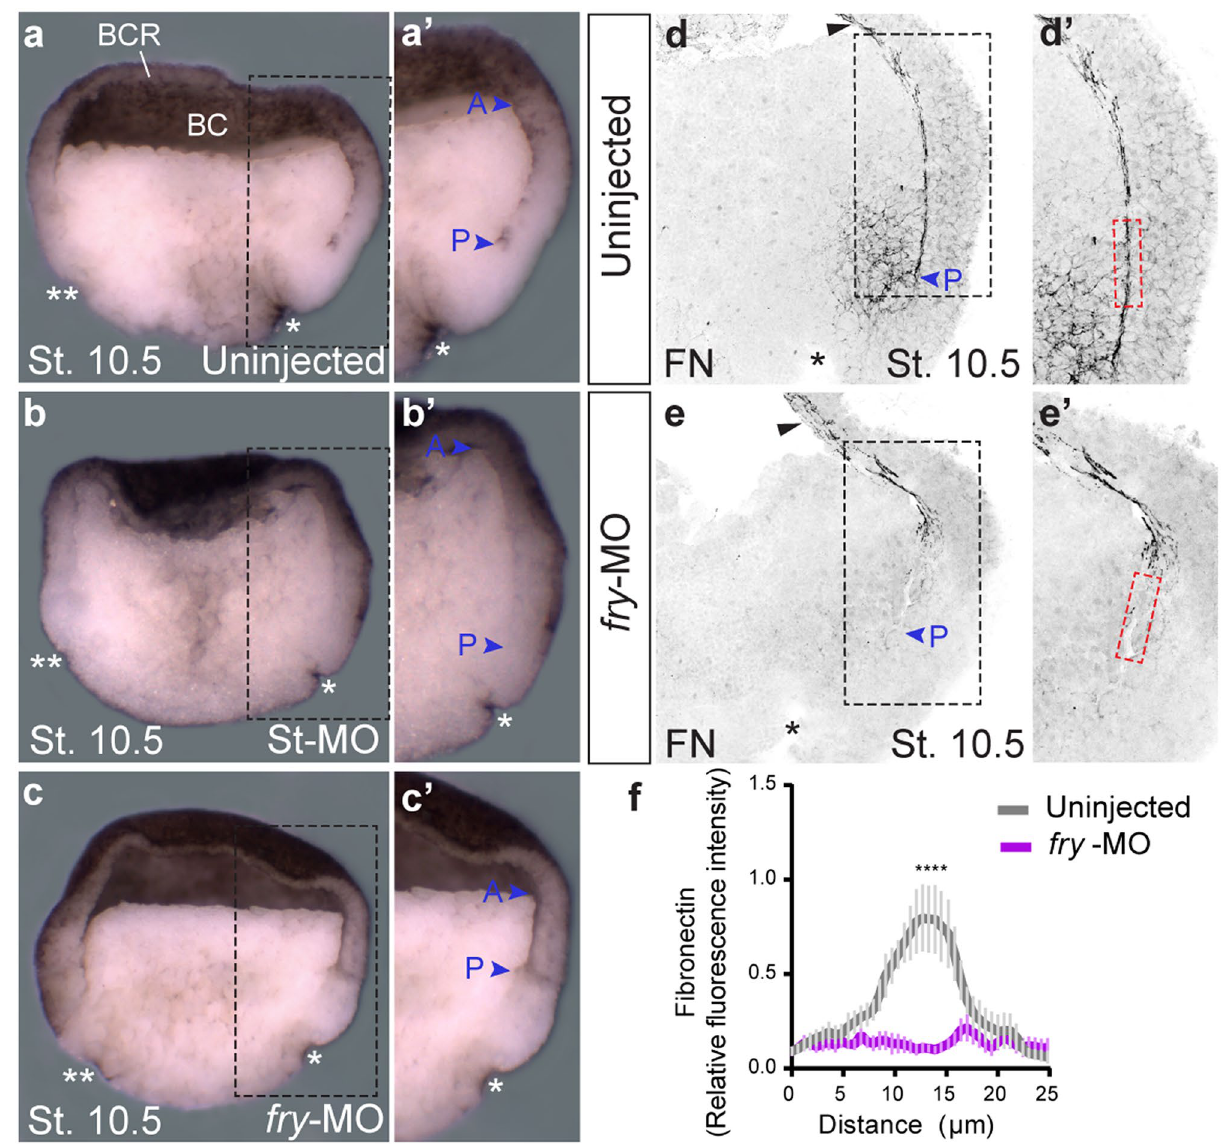
Figure 5. The cleft of Brachet and fibronectin fibrillar matrix formation are affected in fry -depleted embryos. ( a–c ) Formation of the cleft of Brachet on the dorsal side was analyzed in hemisected early gastrula stage embryos (St. 10.5). ( a ) Uninjected embryo (N = 2, n = 26). ( b ) Standard Control morpholino (St-MO) (15 ng) injected embryo (N = 2; n = 13). ( c ) fry -MO (15 ng) injected embryo (N = 2; n = 25, in 92% of embryos, the cleft of Brachet is only present anteriorly). * indicates the position of the dorsal blastopore lip; ** indicates the ventral blastopore lip (morphological feature used as indication that embryos were developmentally synchronized at stage 10.5); blue arrowheads indicate the anterior (A) and posterior ends (P) of the cleft, BC: blastocoel; BCR: blastocoel roof. ( a’–c’ ) Magnifications of the black-boxed area in panels a-c. Representative embryos are shown. ( d,e ) Hemisections of early gastrula stage embryos (St. 10.5) immunostained for fibronectin. ( d ) Uninjected embryo. ( e ) fry -MO (15 ng) injected embryo. Black arrowheads indicate fibronectin presence at the BCR. Blue arrowheads indicate the posterior end (P) of the cleft. ( d’,e’ ) Magnifications of the black-boxed area in panels d and e. For fibronectin quantification, a rectangle 25 μm wide and 100 μm long was drawn at a distance of 300 μm from the dorsal blastopore lip (*) across the cleft of Brachet (red-boxed area). ( f ) Fibronectin abundance was quantified as fluorescence intensity across the 25 μm width of the red rectangle and normalized to the mean fluorescence (see Methods) in uninjected embryos (N = 2; n = 7) and fry -MO (15 ng) injected embryos (N = 2; n = 8). Data in the graph is presented as mean with standard error. Statistical significance was evaluated using two-tailed Mann Whitney U -test. **** p < 0.0001 indicates statistically significant differences between